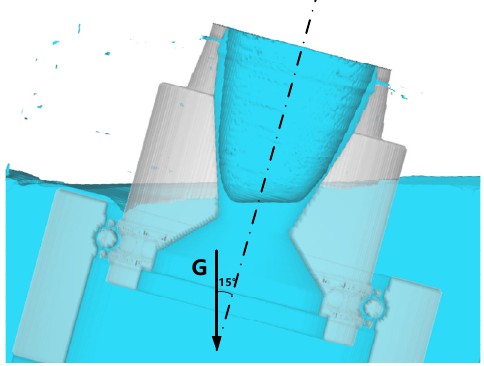
Figure 11. Cross-section of flow field distribution ( α = 15°, t = 1.5 s). angles is obtained as shown in Table 3. When the oil-guiding splash lubrication system is tilted to the spin-in side, the amount of oil splashed to the hollow cavity of the input shaft rotated counterclockwise and the airframe is tilted to the positive direction of the pitch angle and the positive direction of the roll angle, the effective splashed oil amount is greater. Compared with the flight attitude of α = 0°, θ = 0°, the oil feed volume in the target area at α = 15°, θ = 0° and α = 0°, θ = 15° is closer to that in the level posture. In these three